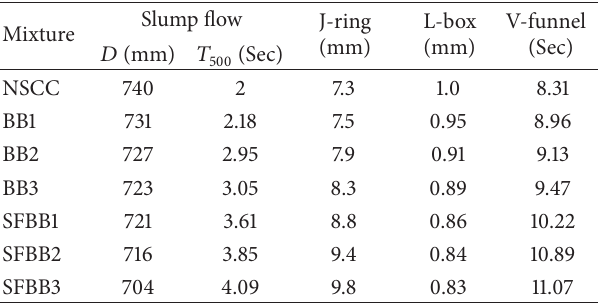
Table 5: Results of fresh state tests on